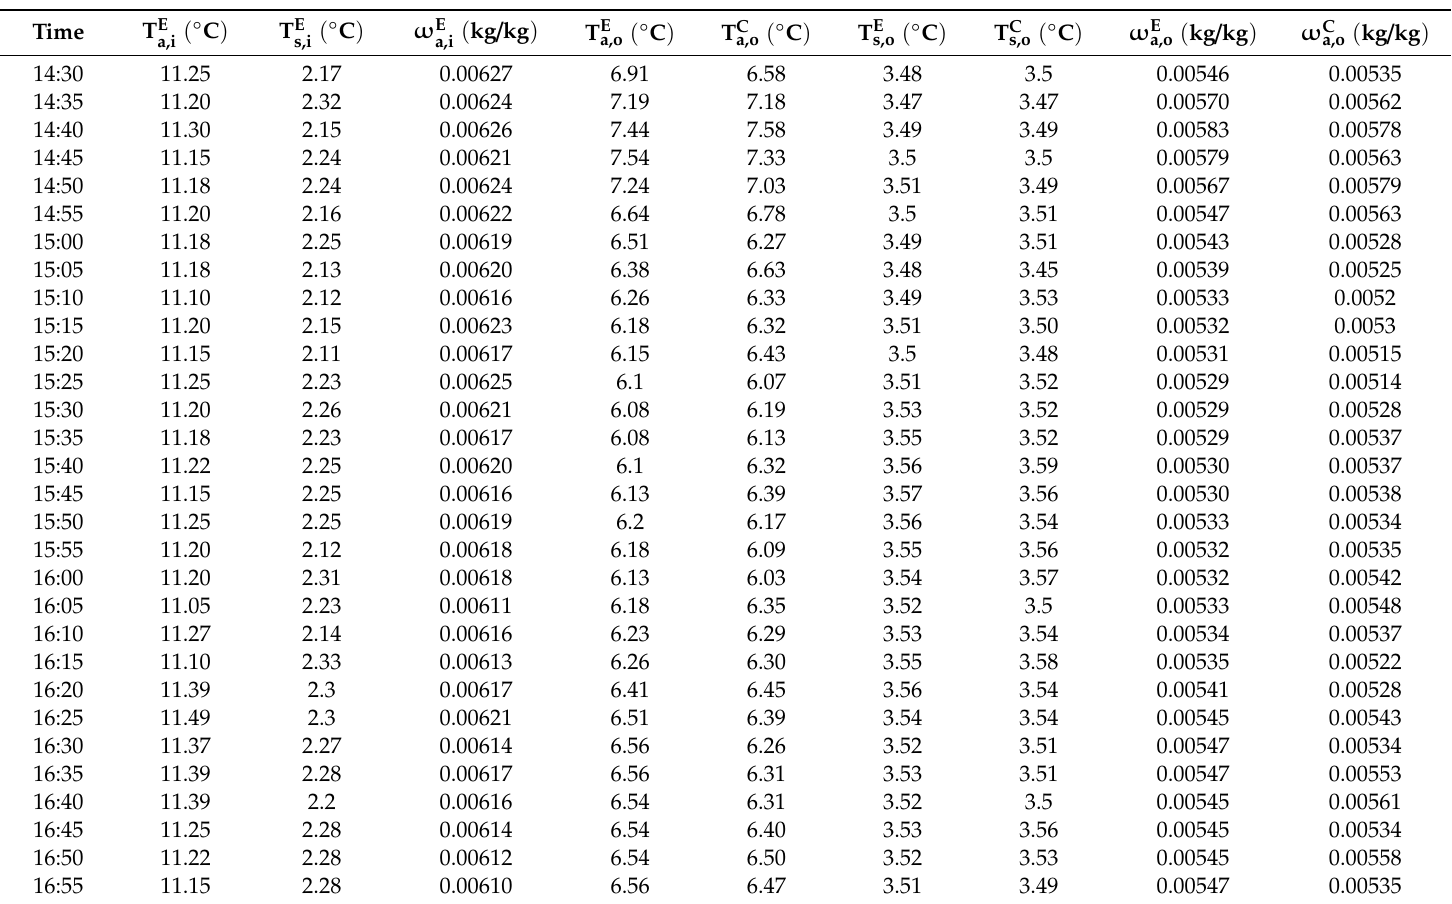
Table A1. The calculated and experimental values of cross-flow